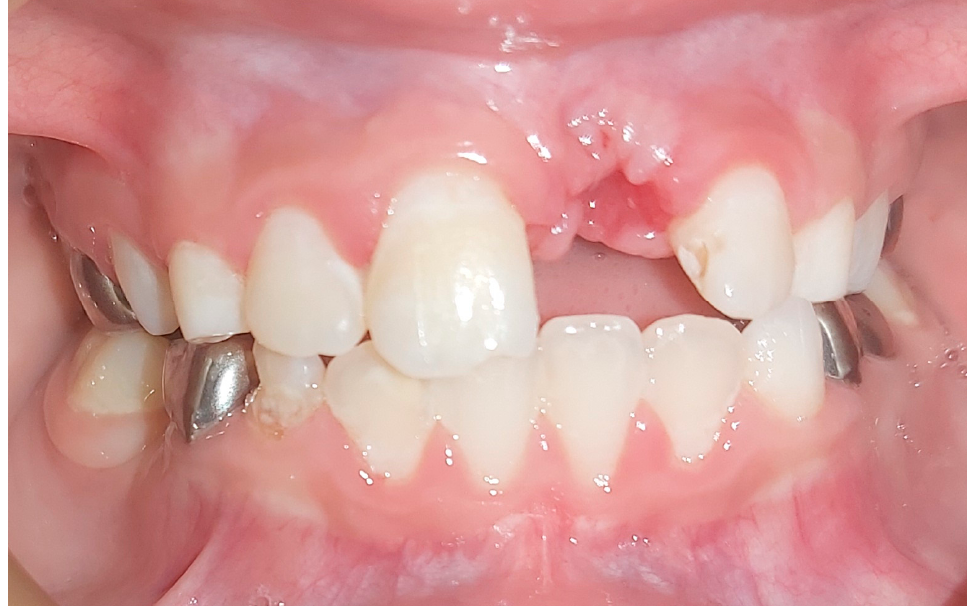
Figure 6. Case 1, four weeks post-surgery. Four weeks after the flapless decoronation procedure, sutures were removed, and epithelization of the treated area was noted.